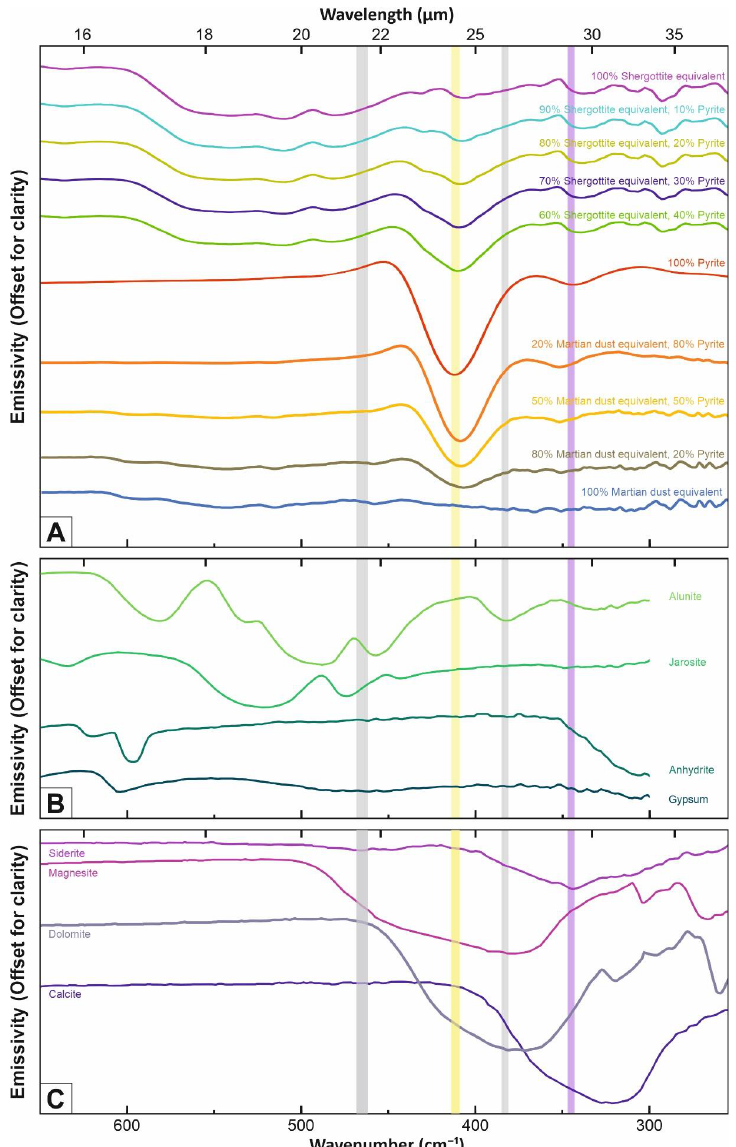
Figure 6. ( A ) presents the emissivity of the Navajún (La Rioja, Spain) pyrite [55], ( B ) equivalents of olivine-phyric shergottites, and ( C ) their various mixtures. The composition of olivine-phyric shergottite equivalents is the same as in the text of Section 3 but normalized from 92% to 100%. The mineral composition of Martian dust is close to JSC Mars-1A (volcanic ash altered at low temperature) proposed by Kölbl et al. [56]: 64% plagioclase (labradorite), 12% olivine (fayalite), 10% magnetite, 9% pyroxene (diopside), and 5% hematite. The input spectra of olivine (fayalite), plagioclase (labradorite), orthopyroxene (bronzite), clinopyroxene (diopside), magnetite, and hematite were collected from the ASU Spectral Library, and was measured by us at the German Aerospace Centre (DLR) in conditions similar to those applied for the ASU measurements: grain dimensions of 710–1000 µ m and a surface temperature of 80 ◦ C, but a pressure of 0.7 mbar instead of a nitrogen atmosphere. Emissivity was calibrated against a blackbody measured at the same temperature as the sample. The simulations of various pyrite and shergottite mixtures were performed using the PFSLook soft- ware [57]. The spectral ranges of four of the six detectors are marked with the rectangles: yellow (409–414 cm − 1 = 24.15 − 24.45 µ m: pyrite), grey (381–385 cm − 1 = 25.95 − 26.25 µ m and 462–468 cm − 1 = 21.35 − 21.65 µ m: reference bands), and purple (343–347 cm − 1 = 28.85 − 29.15 µ m: clinopyroxene). Note that the pyrite absorption band becomes visible (under the reference level in grey) when the pyrite content is at least